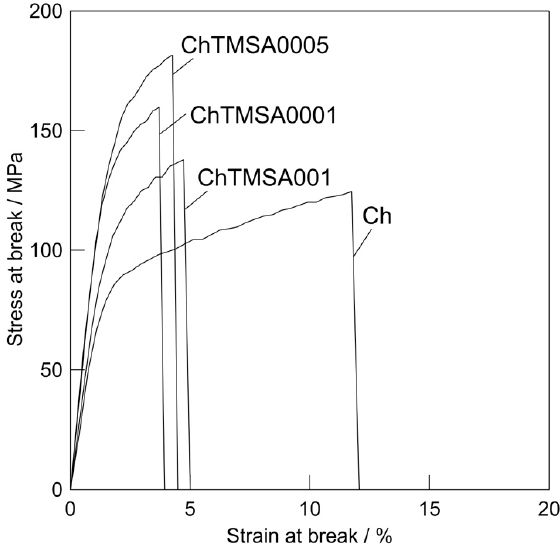
− TMSA microfibers. Molecules 2020 , 25 , x FOR PEER REVIEW